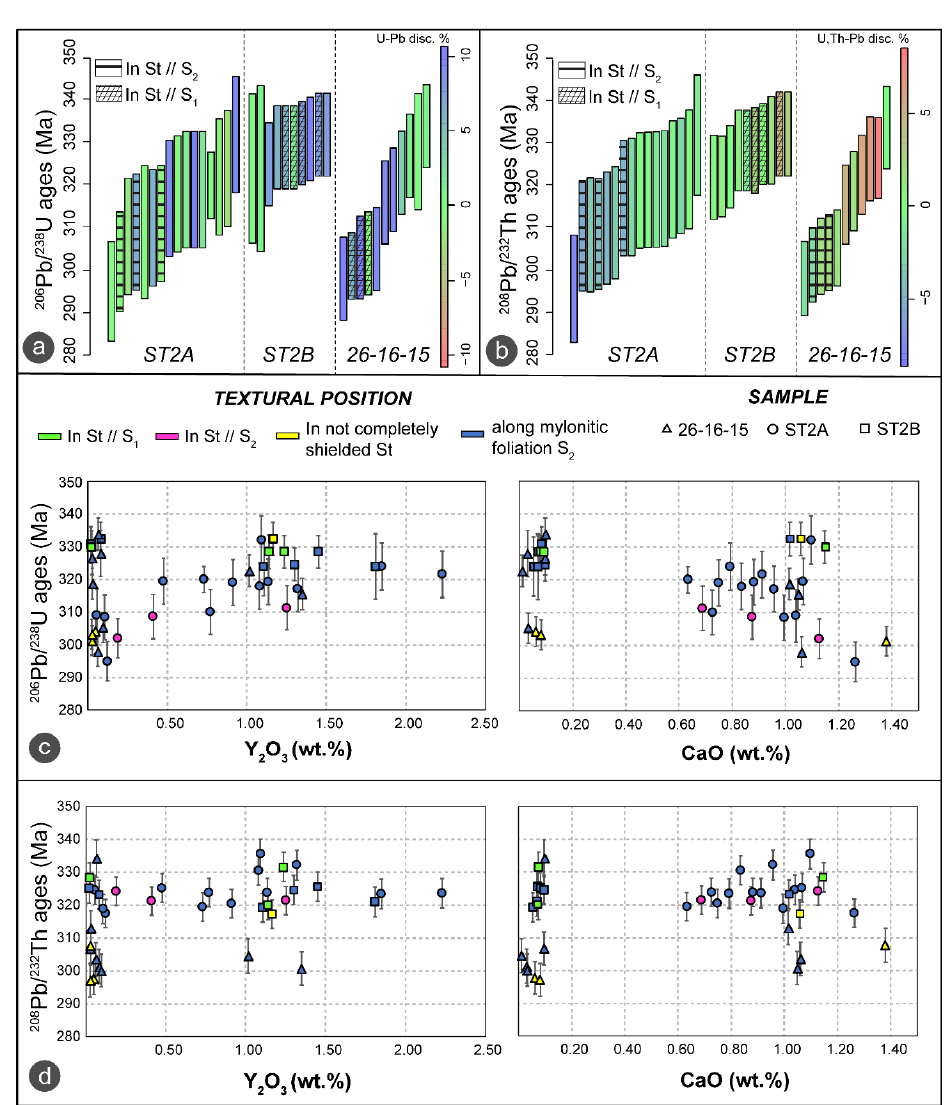
Figure 9. ( a , b ) Distribution of the 206 Pb/ 238 U and 208 Pb/ 232 Th ages of the three analyzed samples. Different textural position of the monazite grains included within the staurolite parallel (//) to the S 1 and the S 2 are indicated; ( c , d ) Dispersion diagrams showing the relations between Y 2 O 3 –CaO (wt.%) with respect to the 206 Pb/ 238 U– 208 Pb/ 232 Th ages with the relative error. Symbols and colors indicate different samples and textural positions, respectively.